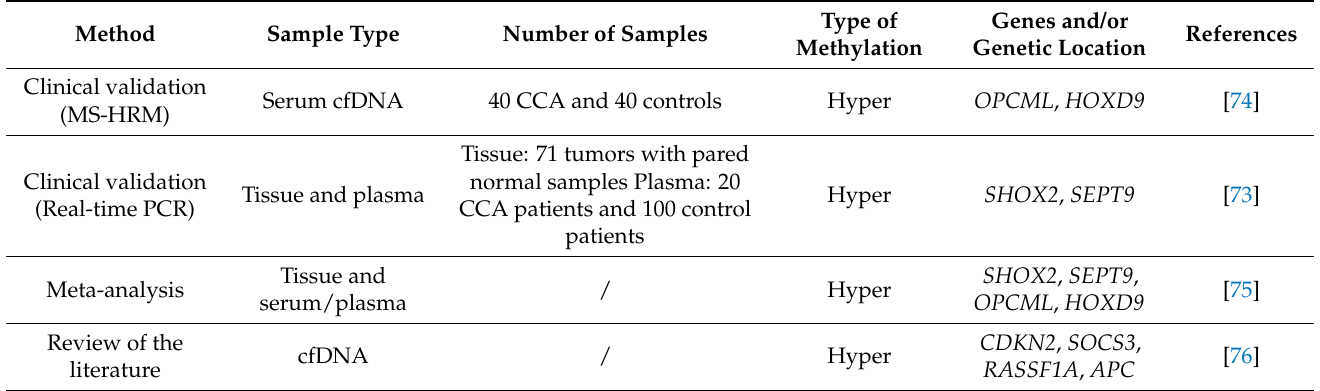
Table 2. An overview of methylation biomarkers for CCA in liquid biopsy. CCA: cholangiocarcinoma; cfDNA: cell-free DNA; MS-HRM: methylation-sensitive high-resolution melting; PCR: polymerase chain